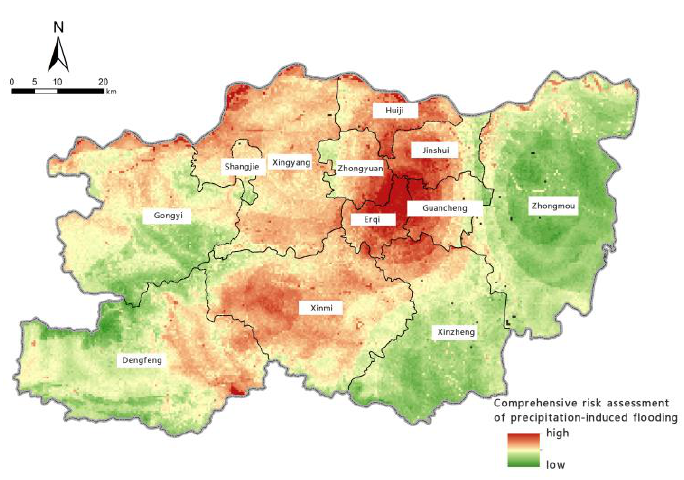
Figure 10. Map of the comprehensive risk assessment of precipitation-induced flooding.